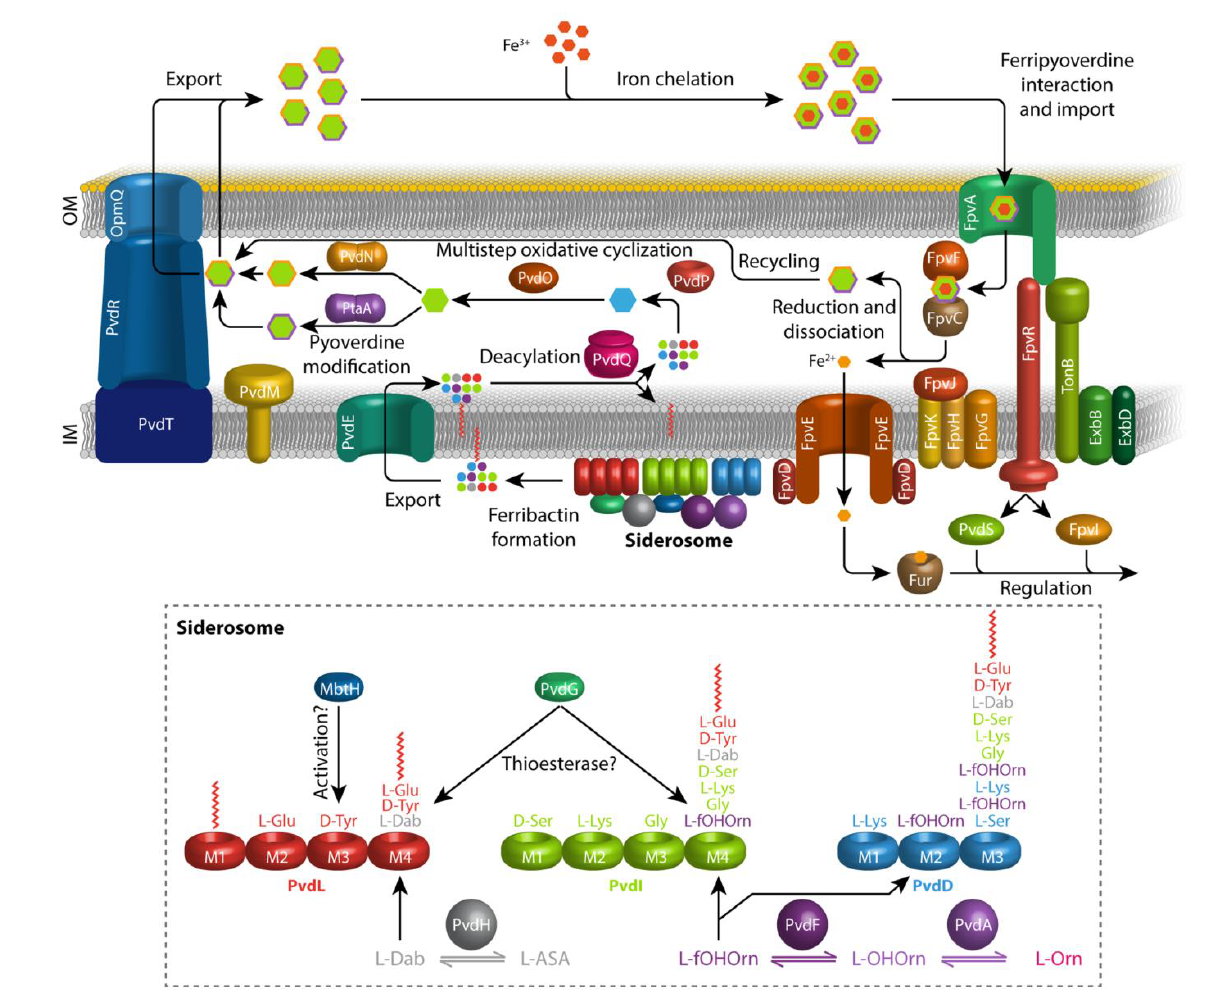
FIGURE 1: Current model for the biosynthesis, secretion, uptake and recycling of pyoverdines in P. fluorescens A506. The acylated ferri- bactin precursor is synthesized in the cytoplasm by NRPSs and auxiliary enzymes organized in membrane associated complexes termed “siderosomes”. The cytoplasmic synthesis is detailed in the box at the bottom. PvdL synthesizes the conserved N-terminal tripeptide with its acylation, the other NRPS are responsible for rest of the peptide and therefore vary between strains with distinct sequences. The auxil- iary enzymes MbtH, PvdG, PvdH, PvdA, PvdF, and PvdD play the indicated roles (see text for details). The acylated ferribactin is exported most likely by PvdE into the periplasm, where it is deacylated by the Ntn-type hydrolase PvdQ. Subsequently, PvdP catalyzes the oxidative cyclization, resulting in dihydropyoverdine. PvdO, possibly in conjunction with other proteins, facilitates the final oxidation, yielding the characteristic pyoverdine chromophore. Thereafter, side-chain modification-pathways transform the original L-glutamic acid side chain either to the succinamide, catalyzed by PvdN, or the α-ketoglutarate, catalyzed by PtaA. The modified pyoverdines are then secreted via various transport systems such as PvdRT-OmpQ, and bind outside ferric iron. The complex binds to FpvA and is TonB-dependently taken up. FpvF and FpvC reduce and dechelate the iron, which is taken up by the FpvDE transporter. The apo pyoverdine is recycled. See text for